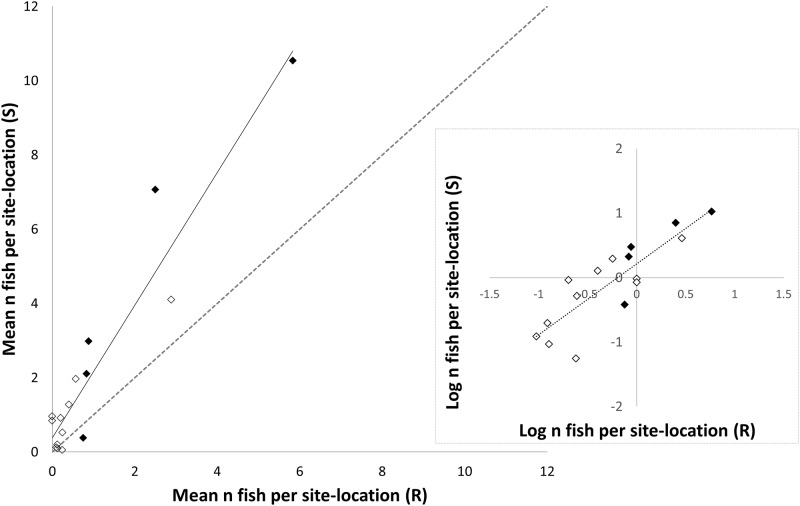
Plot of regression of mean number (n) of fish per site-location (abundance, A) at the Rowley Shoals (R) against the Scott Reefs (S) for 16 species of mesopredatory teleost where AS = 1.79×AR+0.38 (n = 16, p = 1.7×10–8, R2 = 0.90, α = 0.05).Abundance data were sourced from the Australian Institute of Marine Science Long-Term Monitoring Program. The plot includes the five study species (black) and eleven non-focal species (white). The dashed line shows a 1:1 relationship between abundances at each location. Abundance was averaged across 3 sites at each location (Clerke, Imperieuse and Mermaid at the Rowley Shoals and North Scott, South Scott and Seringapatam at the Scott Reefs). The inset figure shows logged values for mean fish abundance per site-location. See Table A in
S1 File and the AIMS website for details:http://www.aims.gov.au/docs/research/monitoring/monitoring.htm.